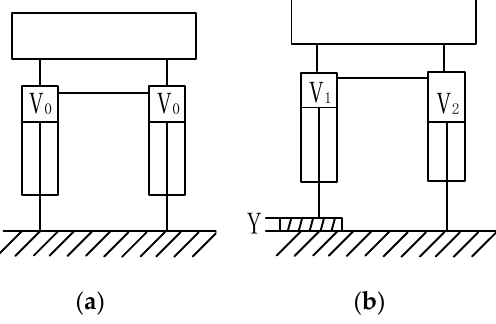
Figure 4. ( a ) The initial state; ( b ) the state of encountering an uneven road.